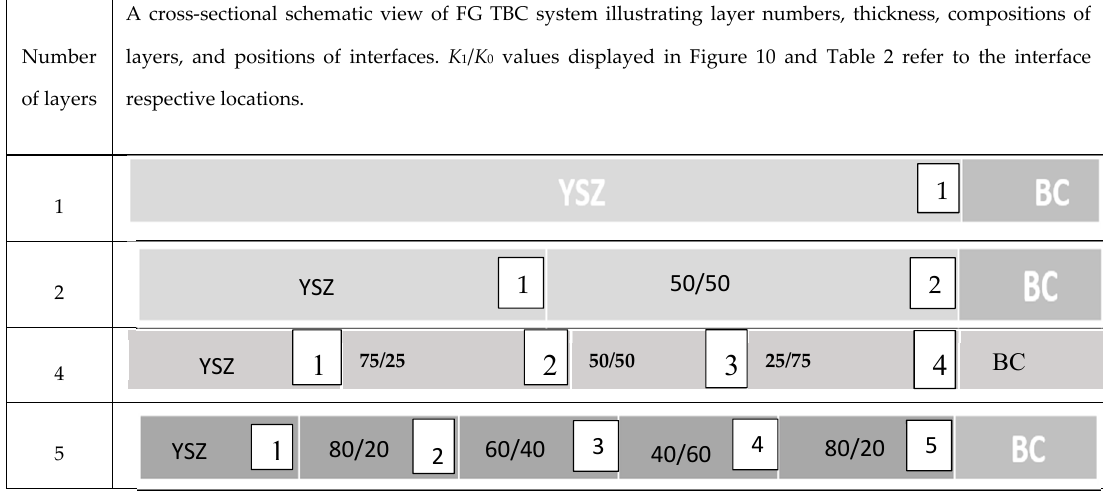
A cross-sectional schematic view of FG TBC system illustrating layer numbers, thickness, compositions of layers, and positions of interfaces. K 1 / K 0 values displayed in Figure 10 and Table 2 refer to the interface respective locations.